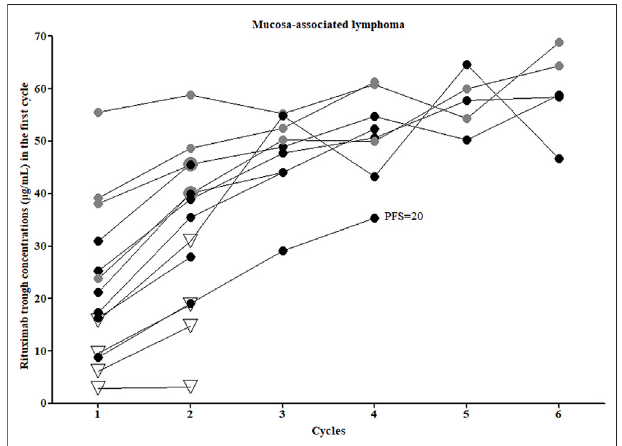
FIGURE1| Rituximabconcentrationsandclinicaloutcomesofmucosa- associated lymphoma patients. Grey dots, patients who received rituximab combined with bendamustine; all other patients were treated with rituximab combined with CHOP. Hollow triangles, patients who did not achieve a complete